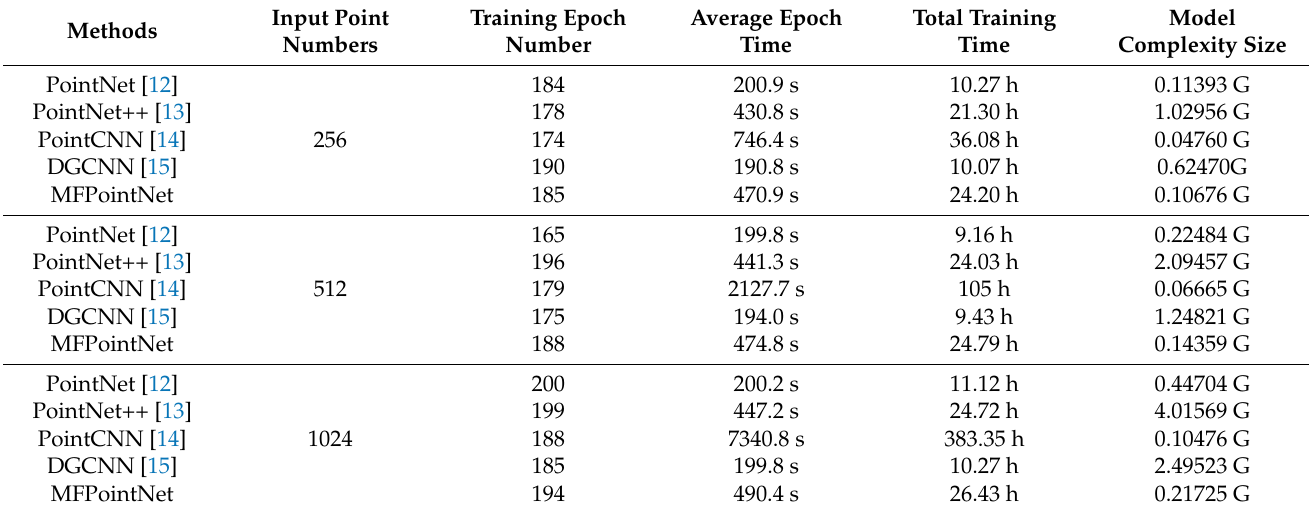
Table 4. The effect of input point numbers on training time and model complexity